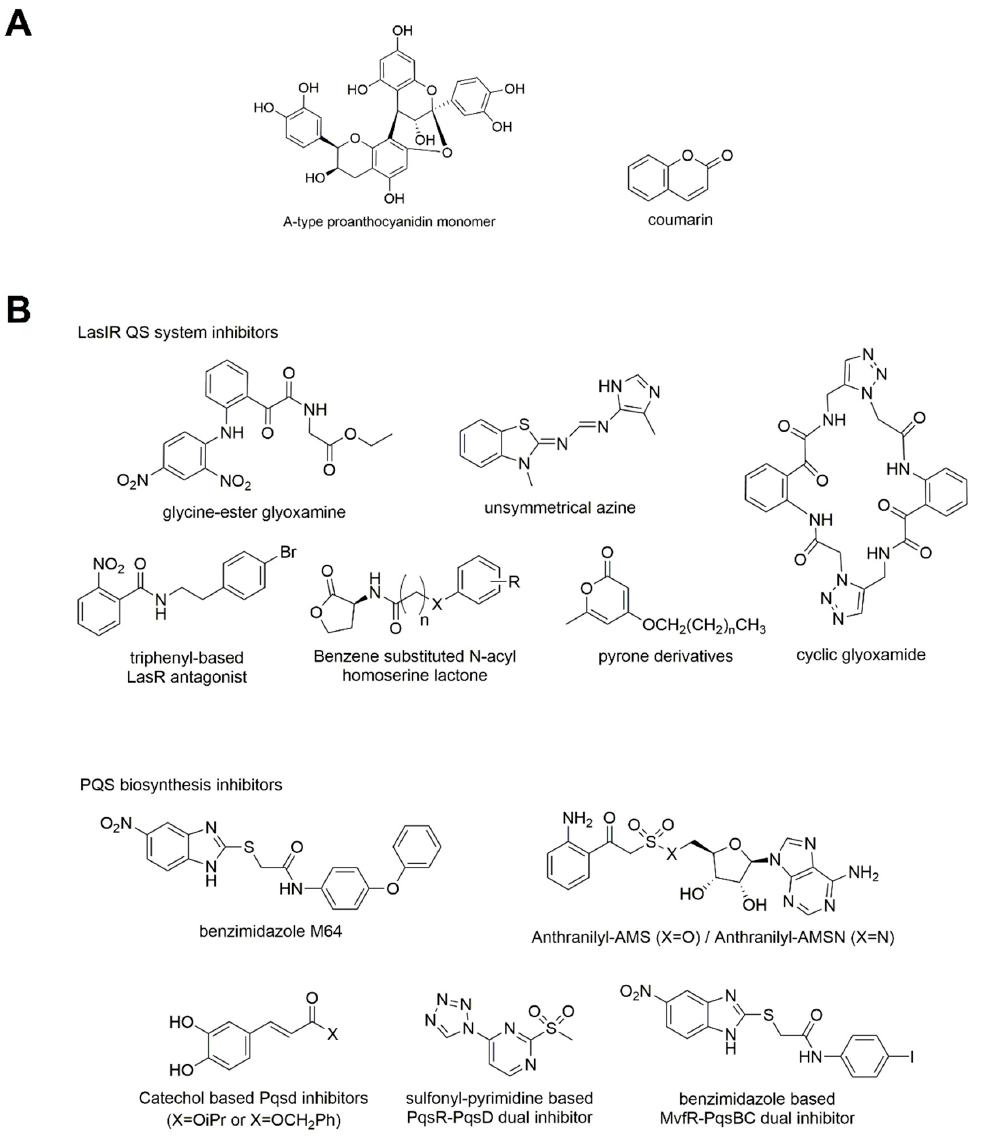
Figure 6. Chemical structures of natural ( A ) and synthetic ( B ) molecules active against P. aeruginosa QS systems.